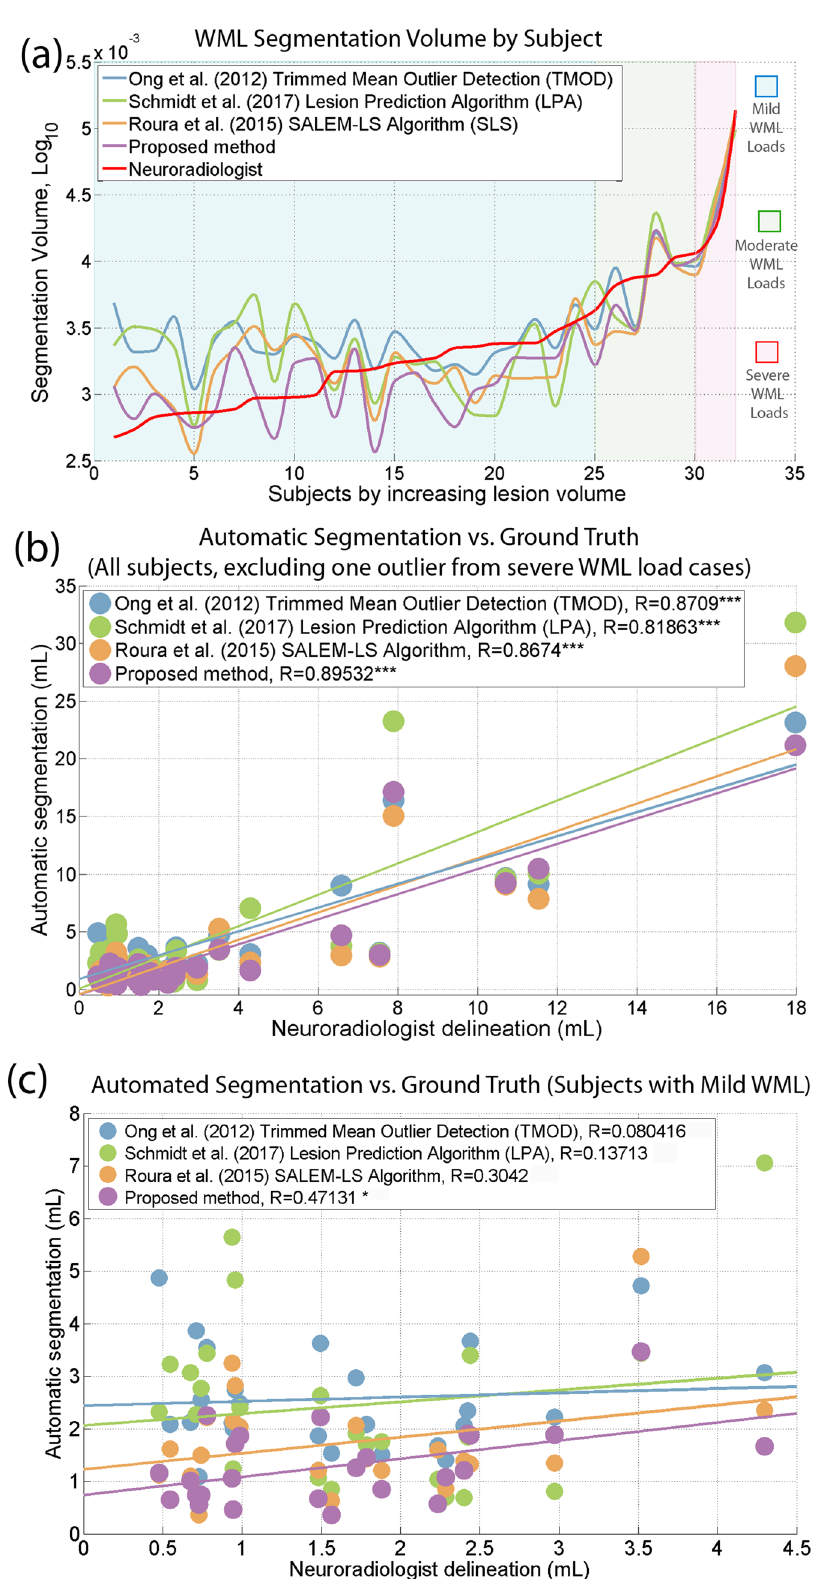
Figure 2. Correlations between automated WML segmentations and ground truth stratified by lesion load. ( a ) The total WML load for each subject manually segmented by the neuroradiologist and automated methods was quantified and sorted by increasing lesion volume in the corresponding ground truth. Subjects were stratified into three WML load groups: mild (< 5 mL, blue background), moderate (5–15 mL, green background) and severe (> 15 mL, red background), also based on the ground truth lesion load. ( b ) A scatter plot of the simple linear regression analysis (32 subjects minus one outlier from severe WML load cases) for WML volume of each automated method compared to the ground truth. ( c ) A scatter plot of the simple linear regression analysis (25 subjects with < 5 mL WML load) for each automated method compared to the ground